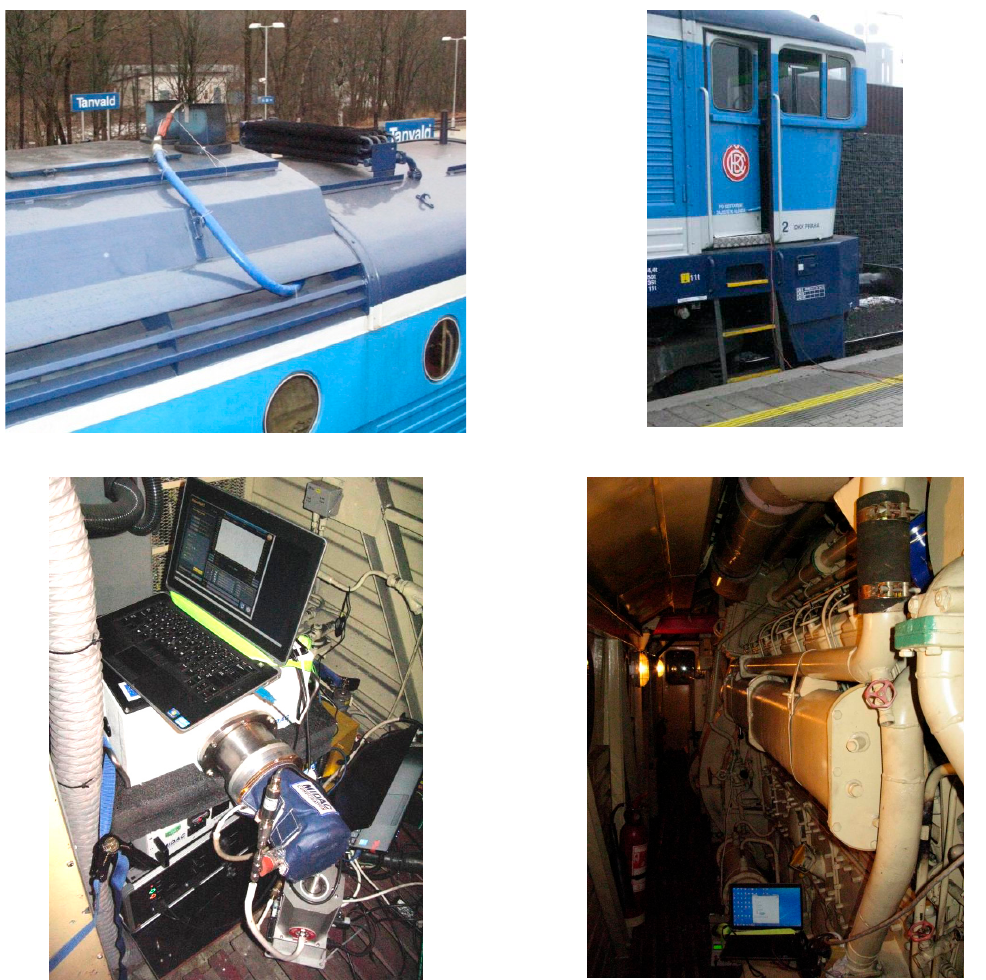
Figure 4. Č KD Series 754 diesel-electric locomotive tests: heated sampling line ( top left ); cabin door detail ( top right ); portable emissions monitoring system ( bottom left ); Č KD K 12 V 230 DR engine ( bottom right ).